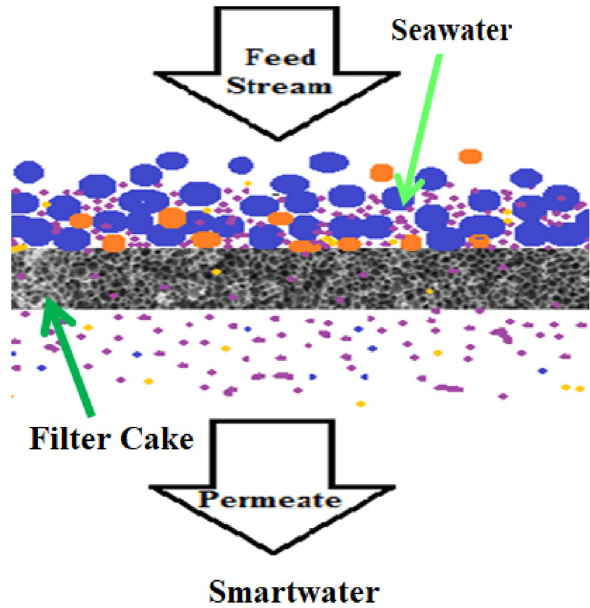
Fig. 1 Description of cake filtration process for SmartWater produc-